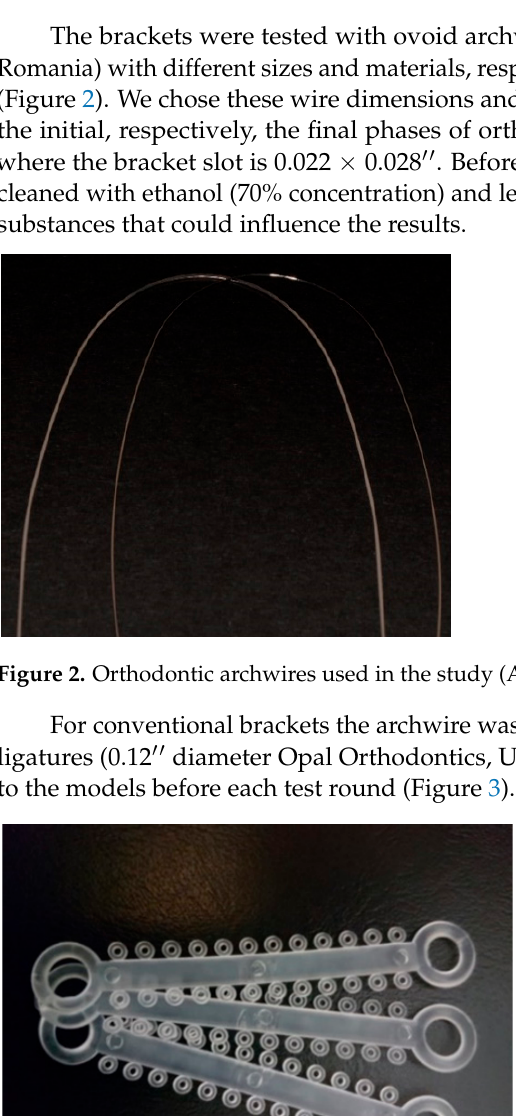
Figure 1. Brackets bonded to standardized model (Spofadent, Fantom Education Models - upper jaw, Kerr Company, Orange, CA, USA).